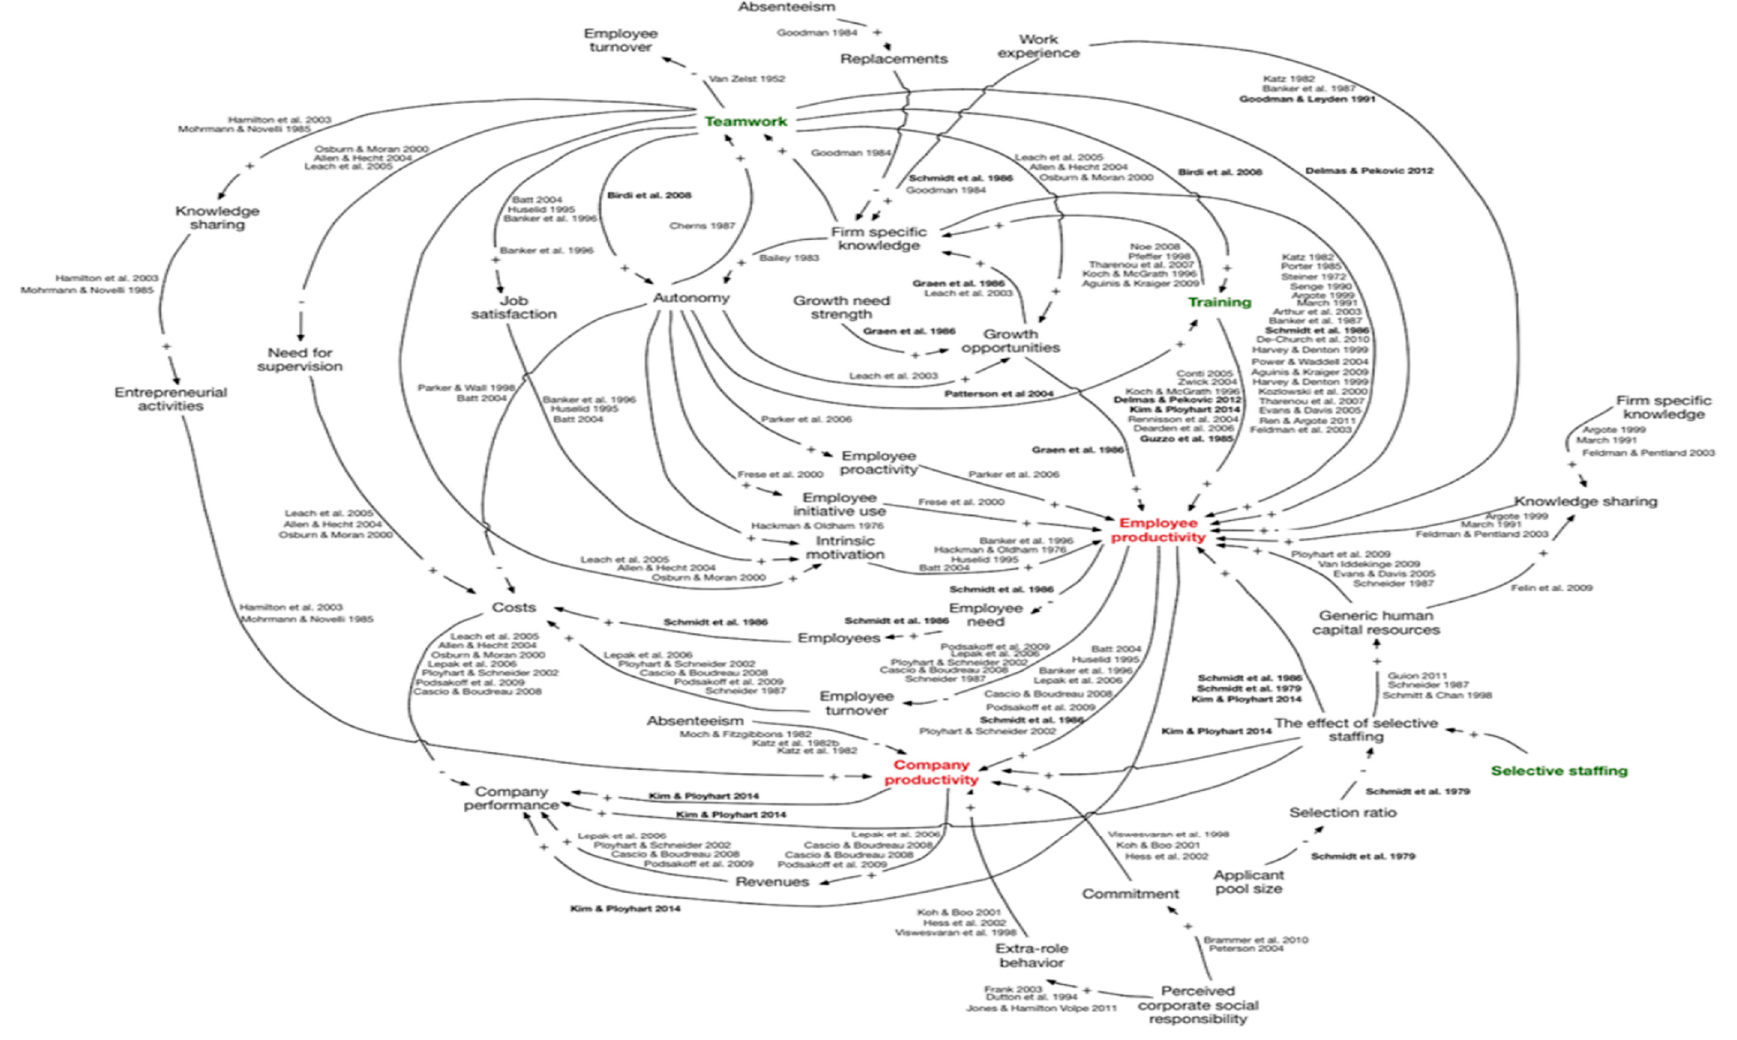
Figure 8. HR management CLD from synthesis step 1.